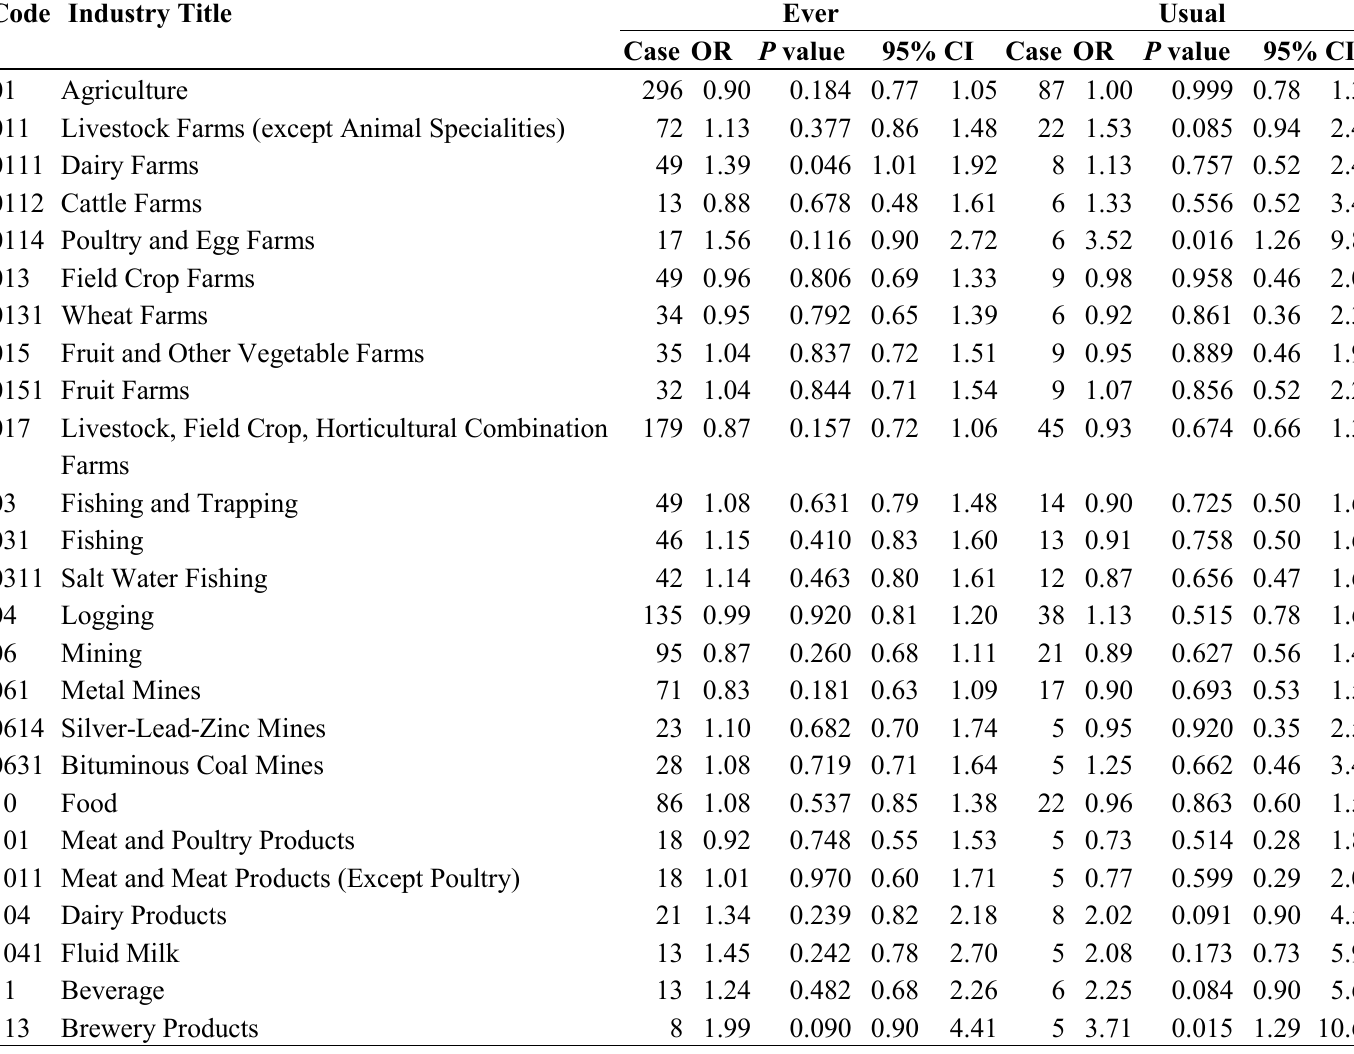
Table 5. Odds Ratios for ever and usual